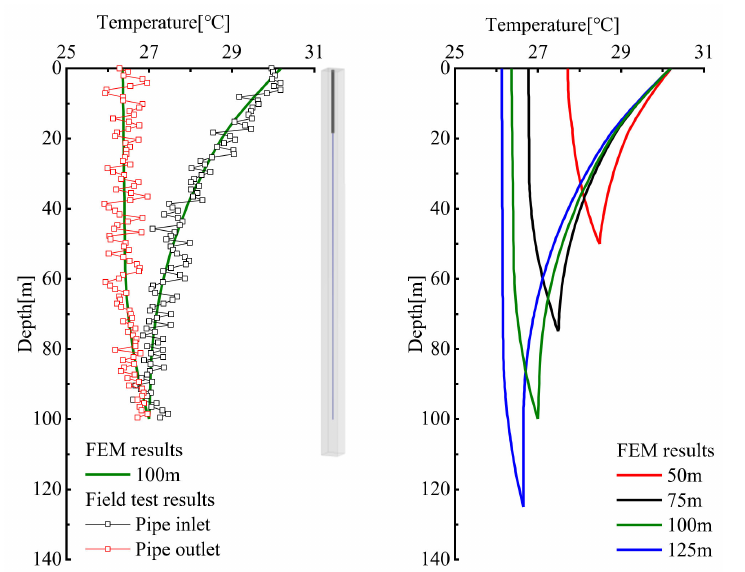
Figure 14. Temperature distribution of #2 pile heat exchange pipe along the depth direction (5.5 kW, 0.6 m 3 /h).